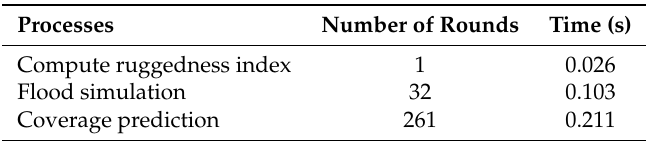
Table 5. Execution times for three processes. There are 58,725 cells in a regular squared grid with a cell size 3 × 3 pixels corresponding to actual area 115 × 115